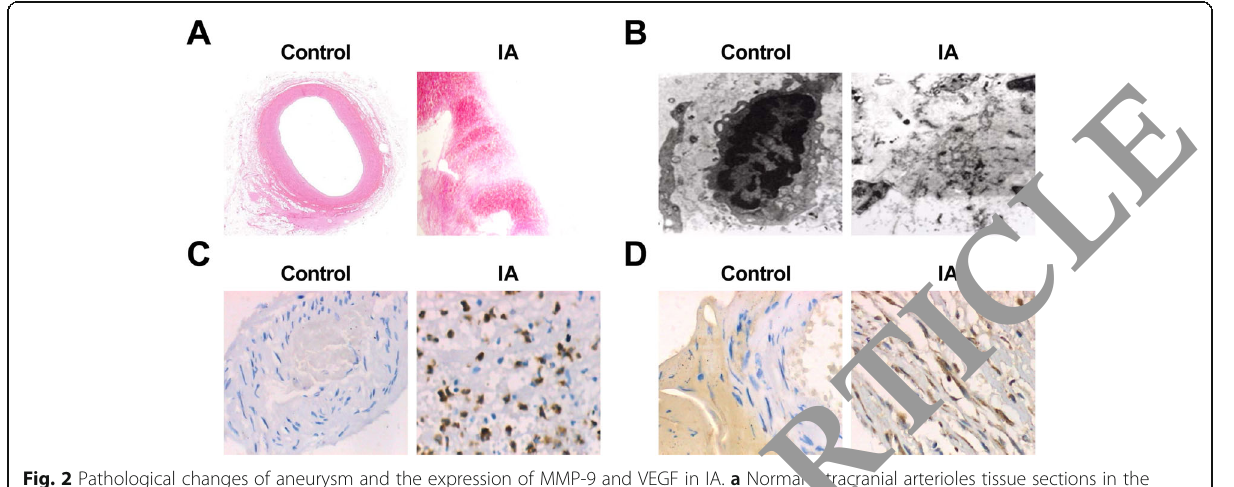
Fig. 2 Pathological changes of aneurysm and the expression of MMP-9 and VEGF in IA. a Normal intracranial arterioles tissue sections in the control group under HE staining (× 10). b IA tissue sections dyed with HE (× 10). c Ultrastructure of normal intracranial arterioles tissues in the control group under an electron microscope (× 10,000). d Ultrastructure of IA tissues under an electron microscope (× 10,000). e Expression of MMP-9 in the control group and the IA group by immunohistochemical staining (× 200). f Expression of VEGF in the control group and the IA group by immunohistochemical staining (×